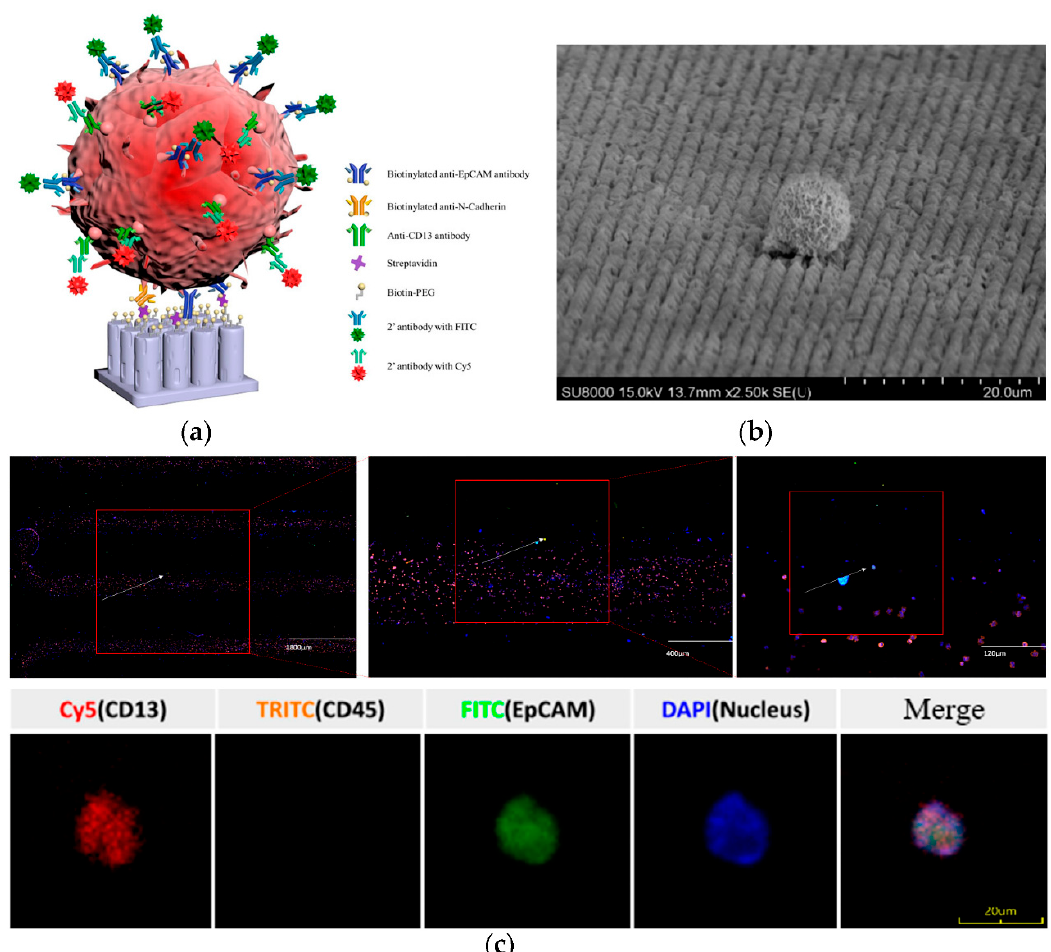
Figure 1. CTCs were captured by the automated Cell Reveal TM system with a nano structure V-BioChip. ( a ) The principle of antibody mediated cell capture. The etched silicon surface of the V-BioChip was coated with biotinylated polyethyleleglycol (biotin-PEG). After preincubating with biotinylated anti-EpCAM and anti-Ncadherin antibodies, CTCs were immobilized by streptavidin that strongly interacts with the biotin-PEG on the surface of the V-BioChip. Captured cells were visualized by secondary antibodies labeled with FITC (targeting anti-EpCAM) and Cy5 (targeting anti-CD13). ( b ) Scanning electron microscopy image of an immobilized cell on the V-BioChip. ( c ) Artificial intelligence assisted targeted cell recognition. Upper panel, identification of cell with FITC, TRITC, Cy5, and DAPI fluorescent signal from the V-BioChip. Lower panel, the fluorescent staining of an identified CTC.